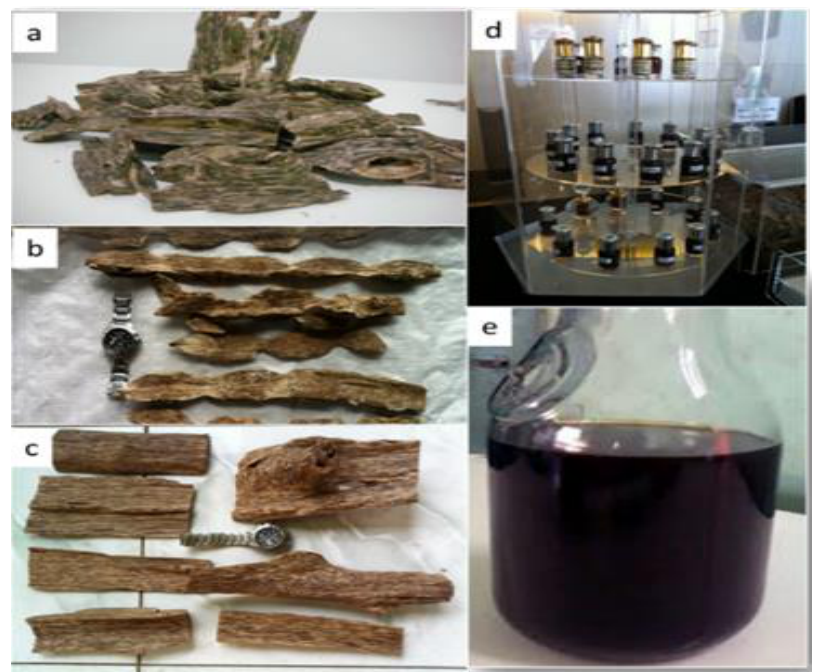
Figure 1. Aquilaria malaccensis Lam. tree (7 years old) can be harvested after three years. They are inoculated by Fusarium solani (Mart.) Sacc., producing the main products of agarwood raw materials with different grades ( a – c ) and agarwood oil ( d , e ).